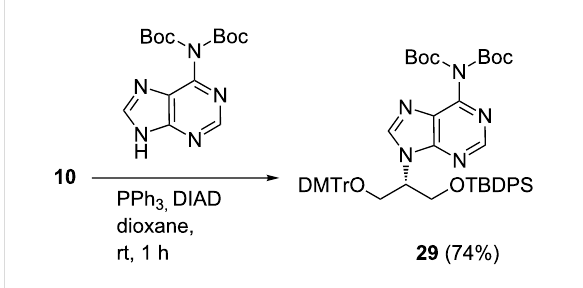
Scheme 5: Mitsunobu reaction with the